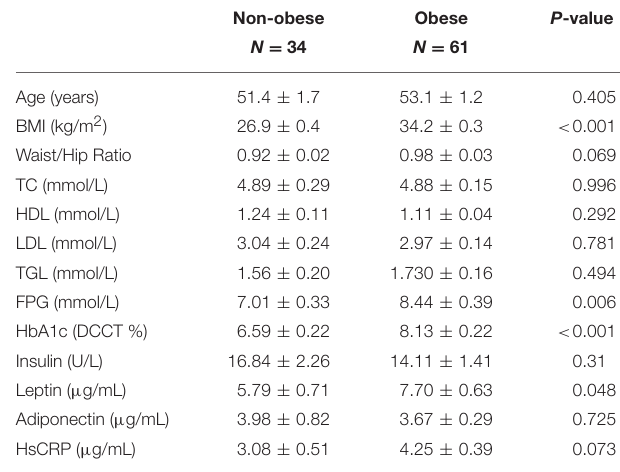
TABLE 1 | Demographics and characteristics of the study based on their diabetes status.